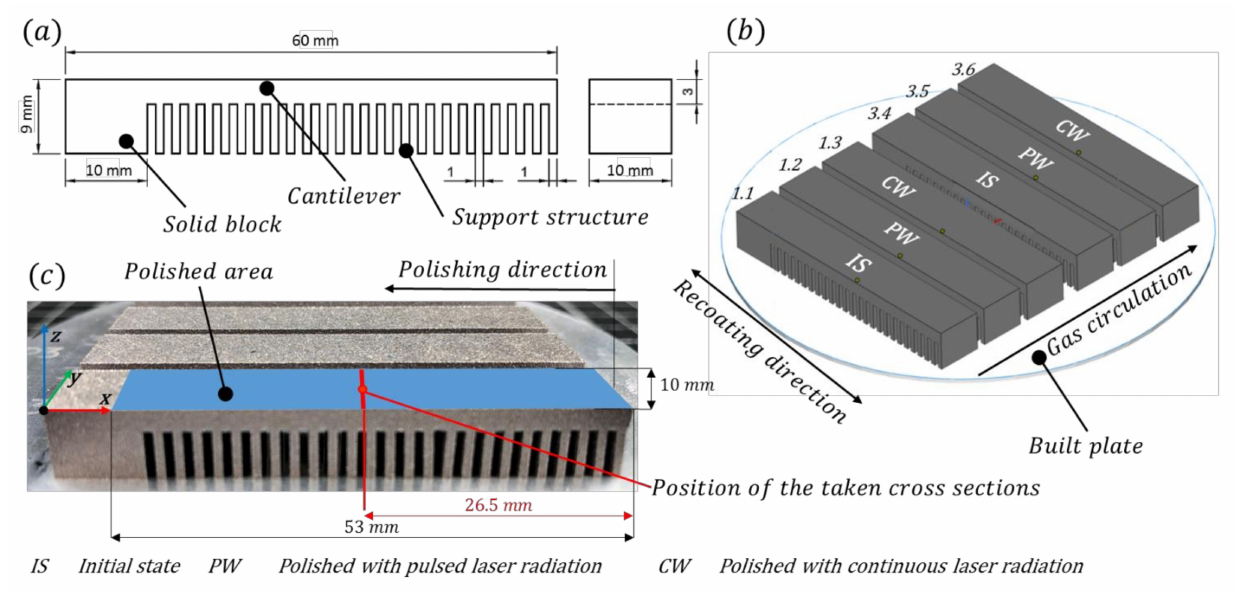
Figure 1. ( a ) Geometry of the cantilever specimens, ( b ) Positioning of the specimens on the built plate during L-PBF in the TruPrint 1000, ( c ) Dimension of laser polishing area and position of the taken cross sections. Table 2. Cantilever sample allocation, labelling and usage for the material investigations. Built